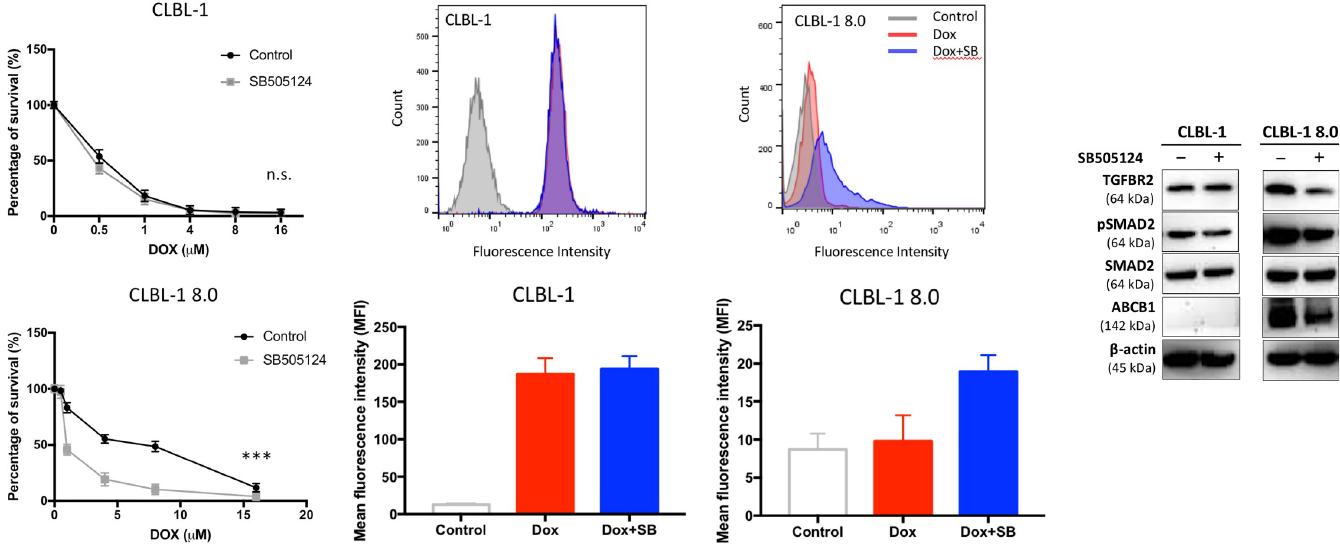
Fig 5. Inhibiting TGF- β signaling pathway reduced Dox-resistance of CLBL-1 8.0. (A, B) Cytotoxicity assay in CLBL-1 and CLBL-1 8.0 cells with the treatment of TGF- β receptor inhibitor, SB505124 (5 μ M), and doxorubicin (Dox). Cytotoxicity assay was performed in triplicate, and error bars represent the SEM of the means. n.s., p > 0.05; ��� , p � 0.001; Dox: doxorubicin; Control: DMSO vehicle. (C) Representative dot plots showing fluorescence channel analysis and (D) quantitative comparison of Dox accumulation in CLBL-1and CLBL-1 8.0 cells after incubation with free Dox or SB505124 (5 μ M) for 2 h at 37˚C. Control: no doxorubicin treatment. (E) Suppressing TGF- β /Smad signaling axis by SB505124 (5 μ M) for 24 hr reduced the quantities of ABCB1/P-gp expression in CLBL-1 8.0 cells.